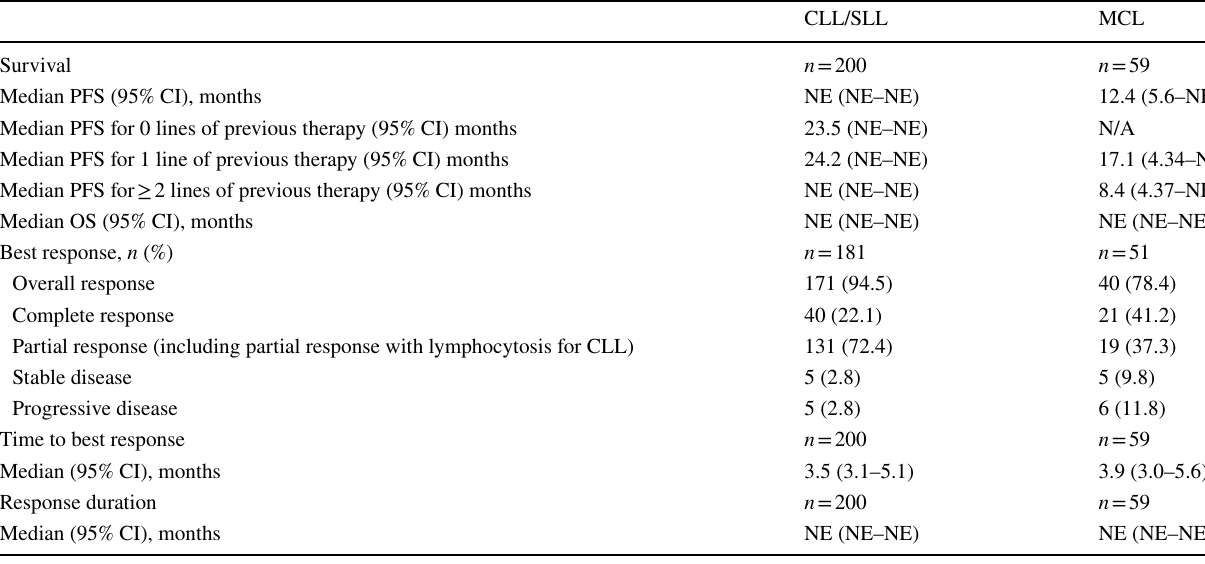
CI confidence interval; CLL chronic lymphocytic leukemia; MCL mantle cell lymphoma; N/A not applicable; NE not estimable; OS overall